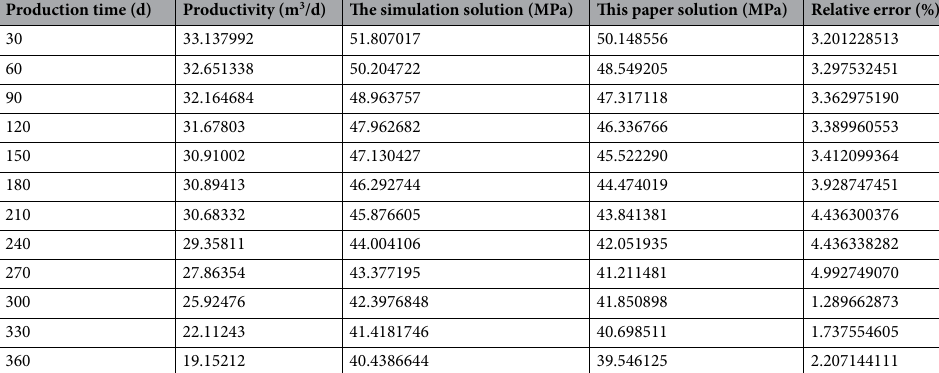
Table 4. Comparison of calculation results.